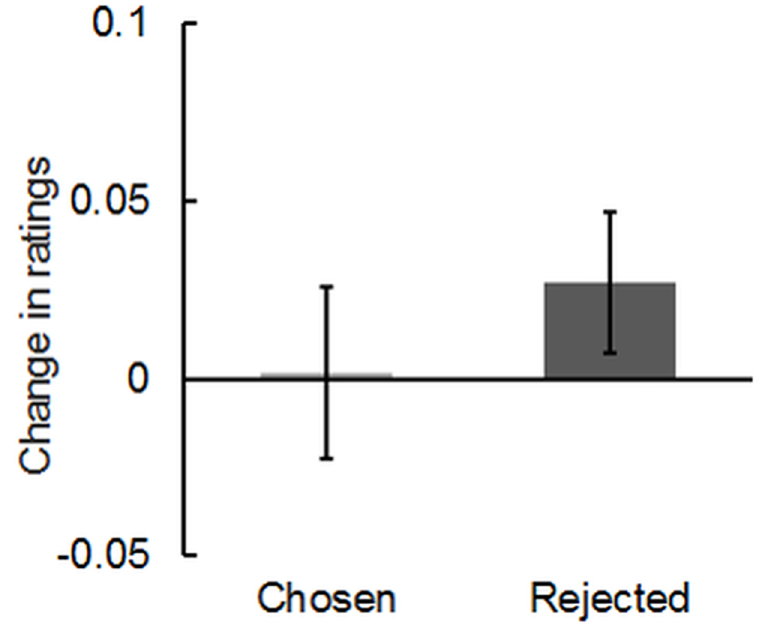
Fig 3. Post-choice change in preference. Changein preference ratings for chosen and rejected images of a landscapeafter blind choice betweentwo equallypreferredimages. Bars represent differences in mean- corrected ratings betweenthe pre-choice rating task and post-choicerating task. Error bars represent standarderrors of the mean.